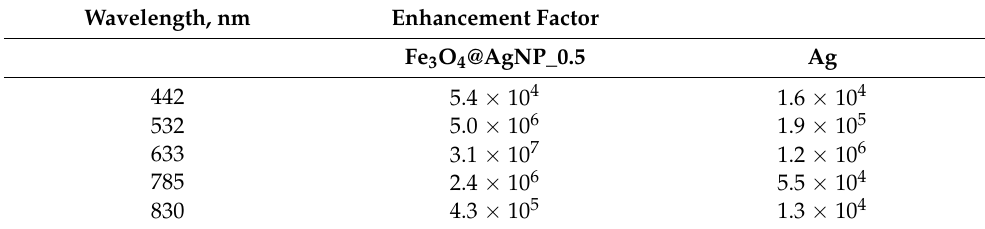
Table 2. Estimated enhancement factors for Fe 3 O 4 @AgNP_0.5 and